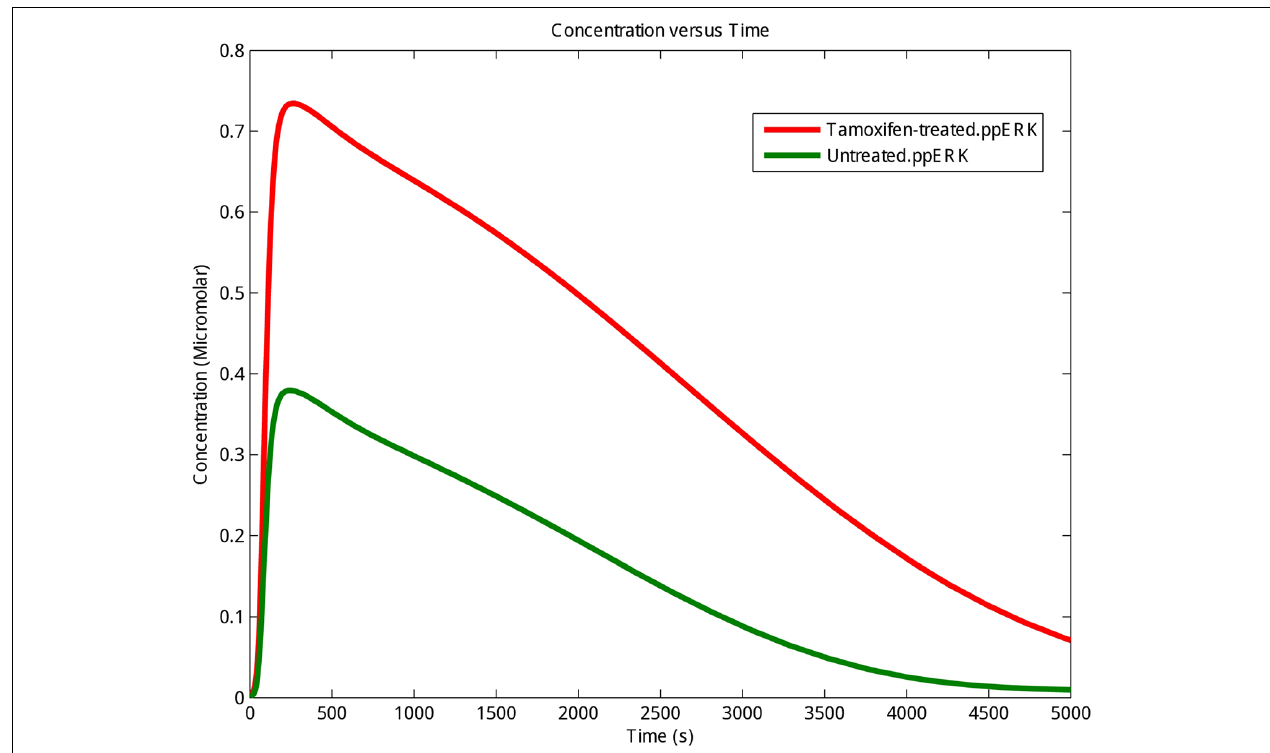
FIGURE 2 | The kinetics of phosphorylation and activation of ERK protein. The activating phosphorylation of ERK (ppERK) was enhanced under tamoxifen stimulation. Control (Untreated cells): Green graph; Tamoxifen-treated cells: Red graph.